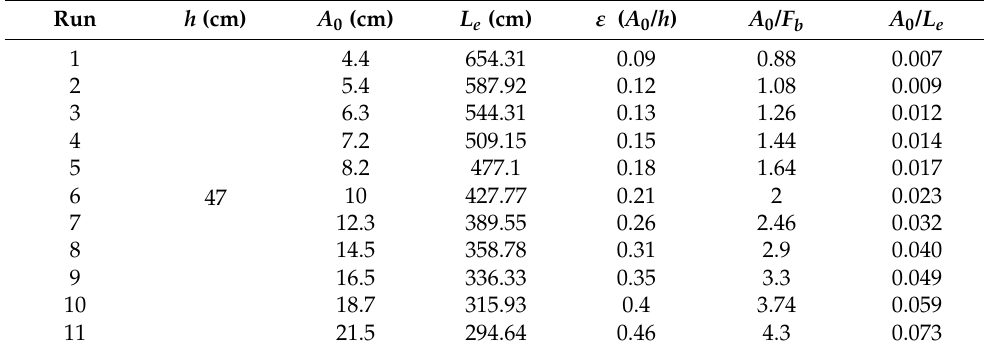
Figure 1. Wave flume and test setup: ( a ) vertical revetment (VR); ( b ) wave absorbing revetment (WAR). Table 1. Experimental conditions used in this